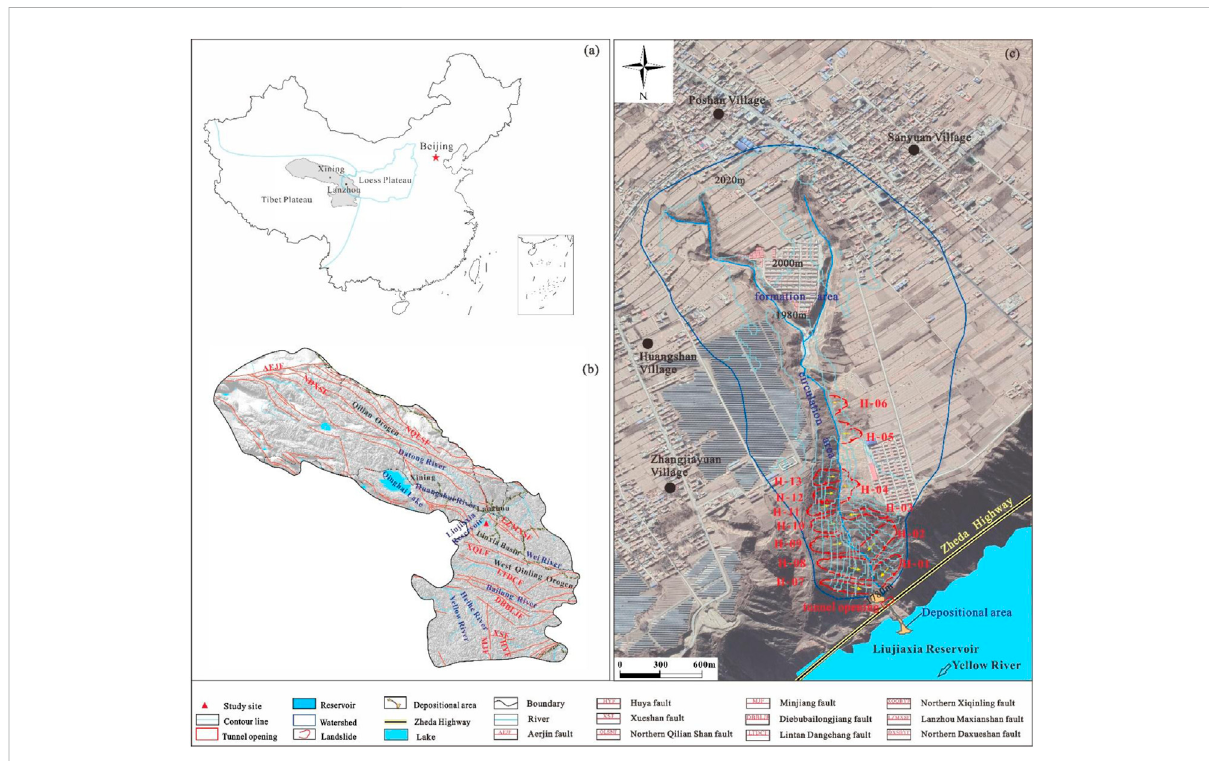
FIGURE 1 Simpli fi ed topography and geological setting of the Zhangjiayuan watershed (A) location of the study area in the transitional regions of Tibet Plateau and Loess Plateau, (B) geological setting of the study area and (C) simpli fi ed topography of the study area.